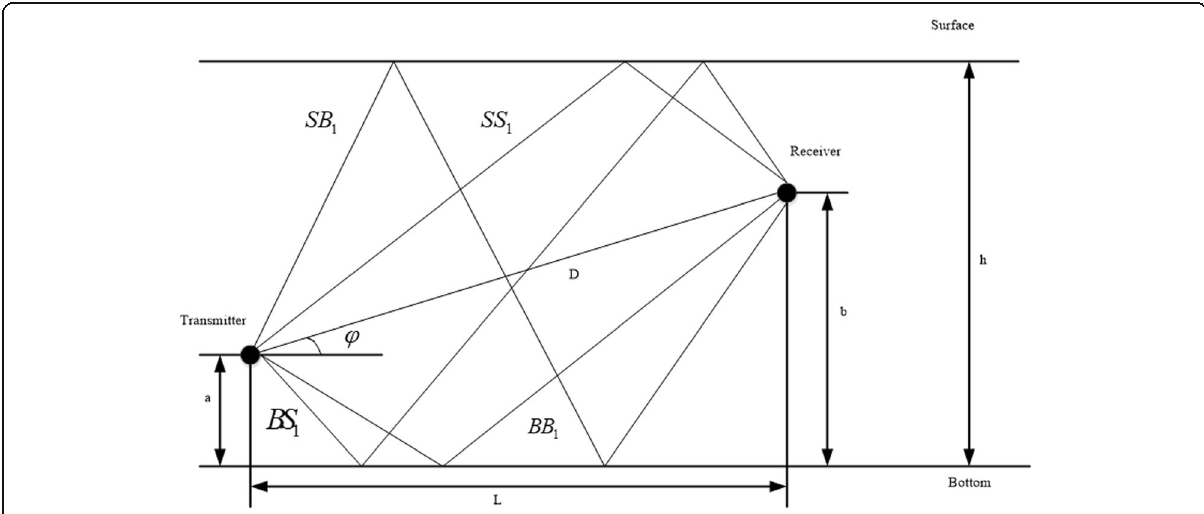
Fig. 1 The ray model in underwater acoustic